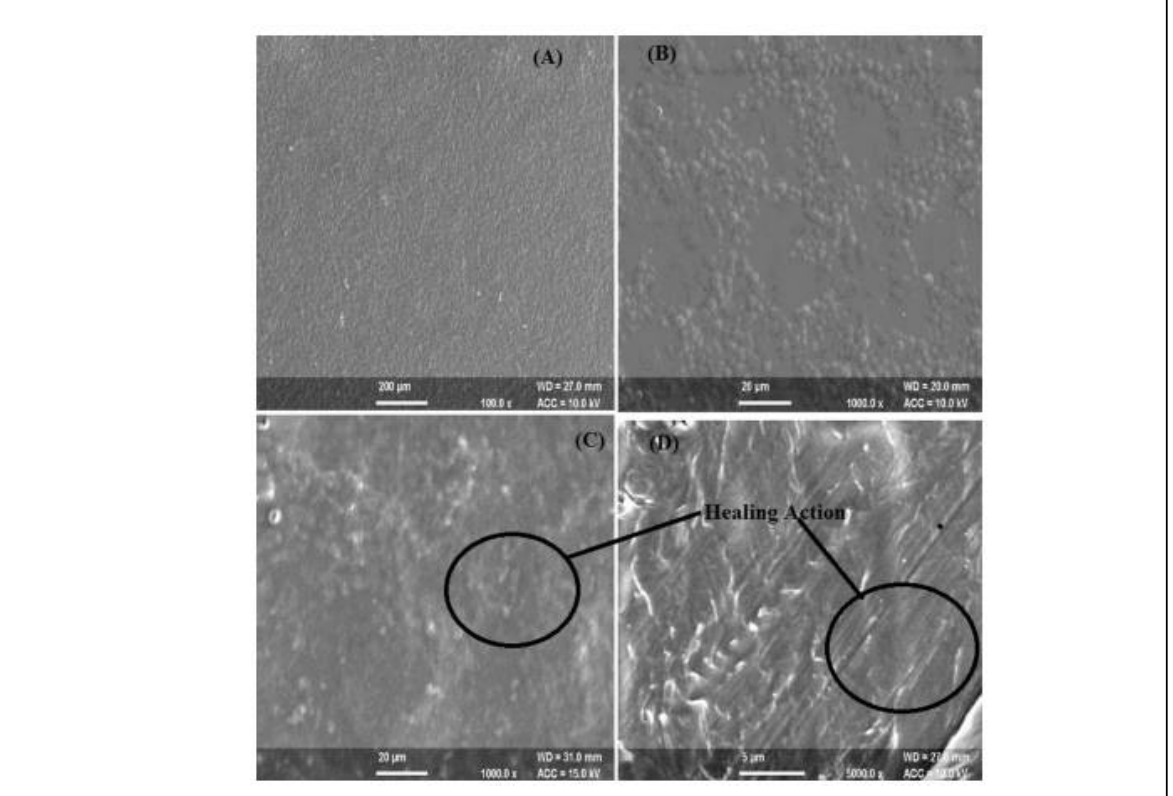
Figure 5: SEM images of citric acid modified (a), potato starch films (b) and, CA-starch/gelatin composite films (c), (d). Retrieved from Kumar et al. 2019